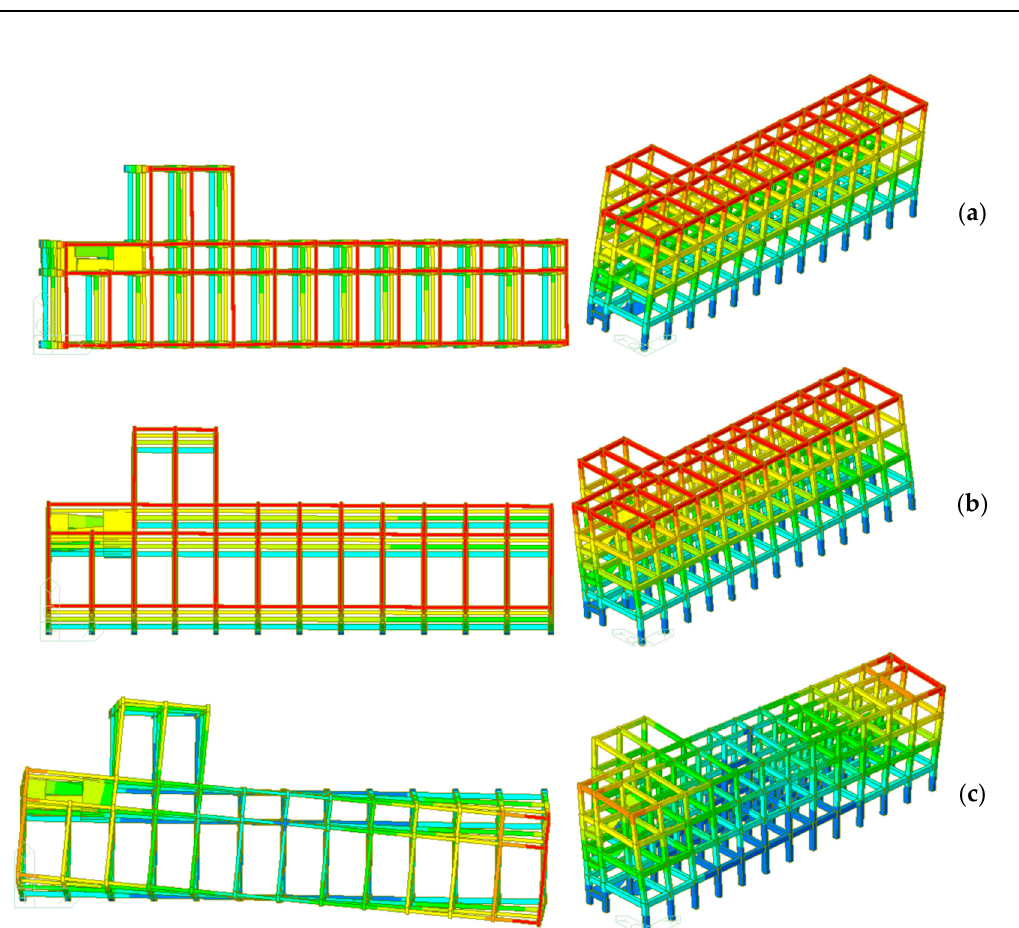
Figure 9. Fundamental vibration modes of the MU system (Midas): top view and axonometric view. ( a ) Mode 1 T 1 = 0.5542 s (M = 75.02%). ( b ) Mode 2 T 2 = 0.4648 s (M = 76.82%). ( c ) Mode 3 T 3 = 0.4515 s (M = 76.45%).